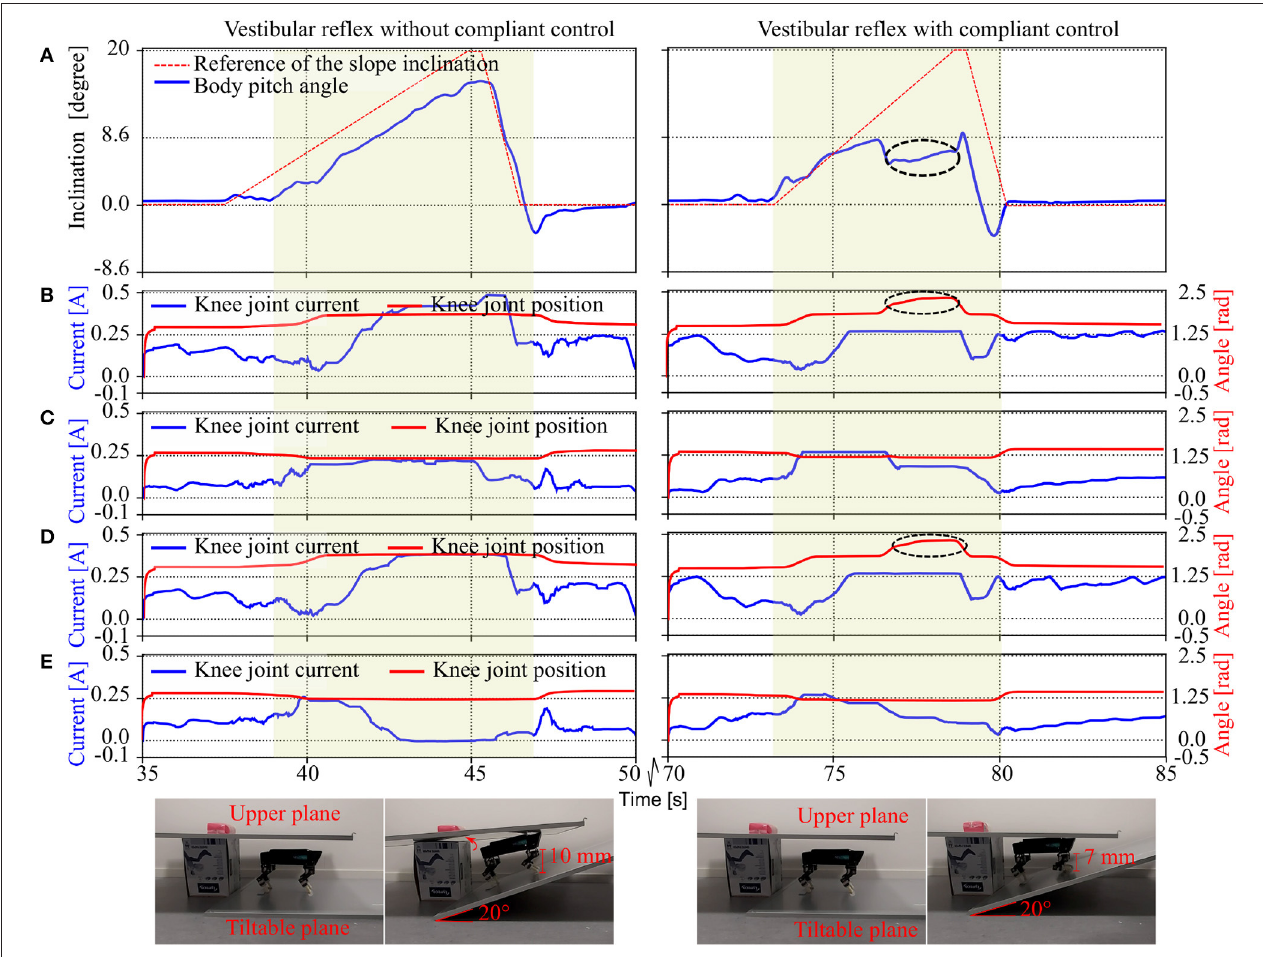
FIGURE 12 | Body stabilization on a tiltable plane with negotiating a payload under vestibular reflex control without and with compliant control. (A) The pitch angle of the robot and the reference inclination of the tiltable plane. (B–E) are the knee joint positions and currents of the right front (RF), right hind (RH), left front (LF), and left hind (LH) legs, respectively. The yellow colored areas mark the period when the plane was inclined upward. Black circles on the right graphs indicate that the front legs of the robot exhibited compliance to negotiate the payload (B,D) . Due to the compliance, the knee joints could flex instead of rigidly resisting the payload, thereby consuming lesser current compared to the case of the pure vestibular reflex control (left graphs). The flexing knee joints could decrease the pitch angle of the robot body [right graph (A) ], thereby sustaining the body